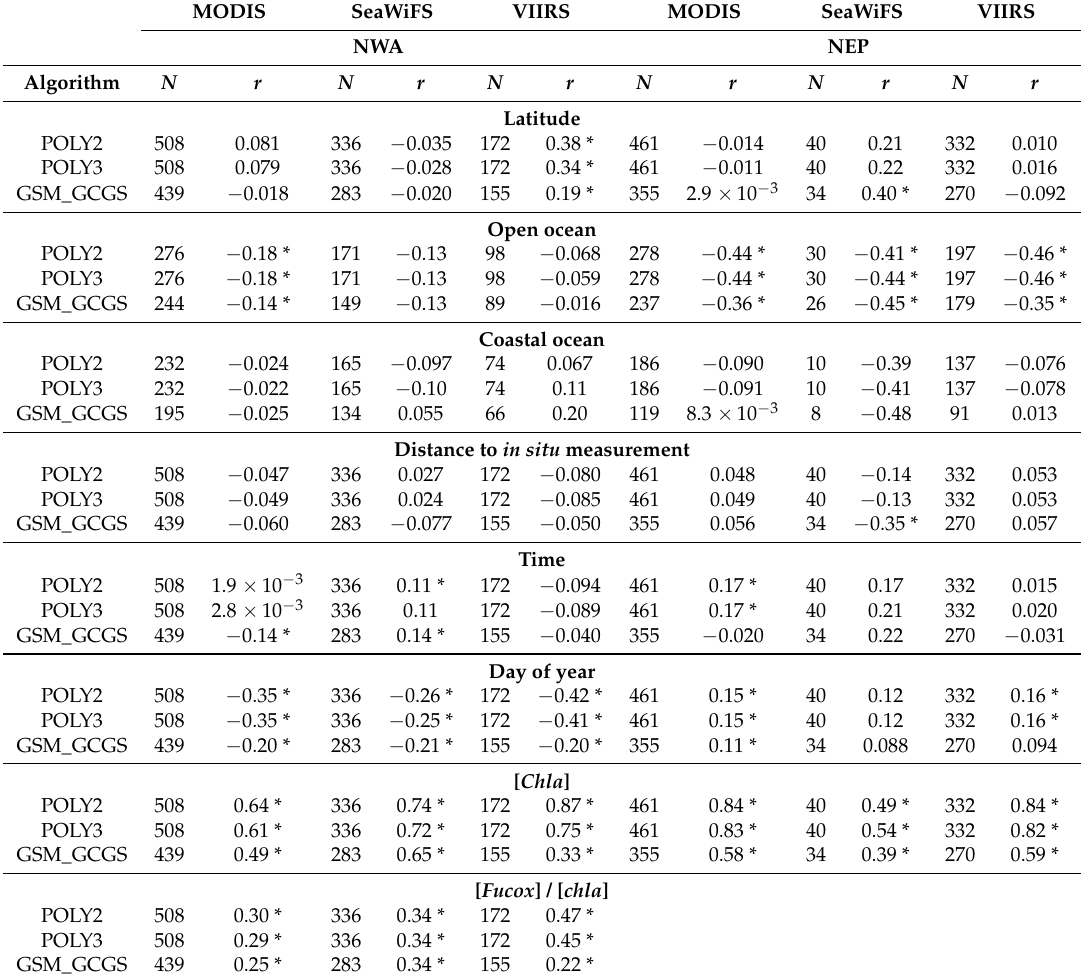
Table A2. Pearson’s correlation coefficients ( r ) from the test for correlation between | E chla | and environmental factors (see Section 2.6) for model versions not presented in the text. * = statistically significant ( p -value <